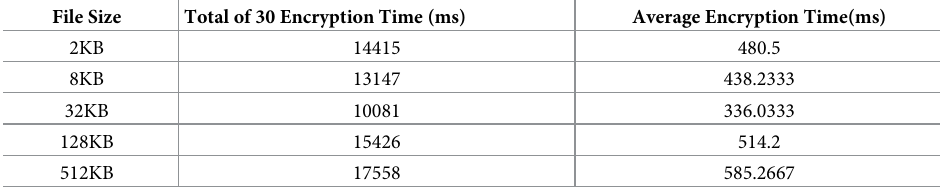
Table 3. The proposed total encryption and average encryption time of NCS.